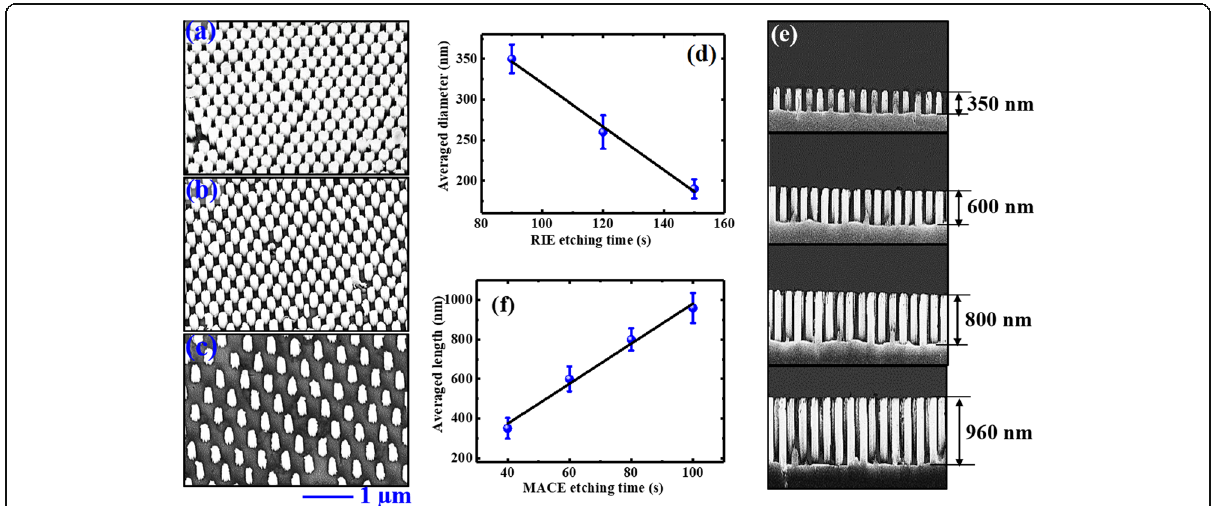
Fig. 2 Top view SEM images of Si NWs with same length of 350 nm, but different diameters of a 350 nm; b 260 nm; and c 190 nm. The dependence of NWs ’ diameter on the RIE etching time is plotted in d . e Cross-sectional SEM images of Si NWs with same diameter of 260 nm, but different lengths of 350, 600, 800, and 960 nm. f Presents the dependence of NWs ’ length on the MACE time